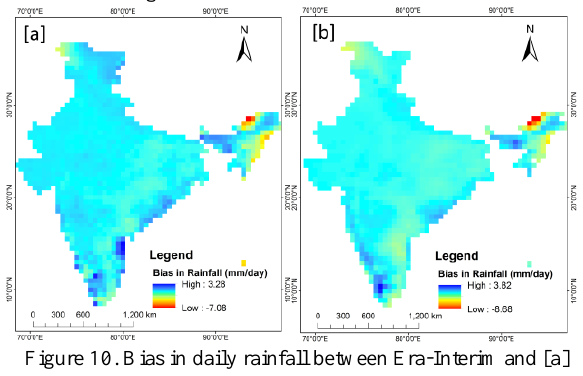
Figure 10. Bias in daily rainfall between Era-Interim and [a]